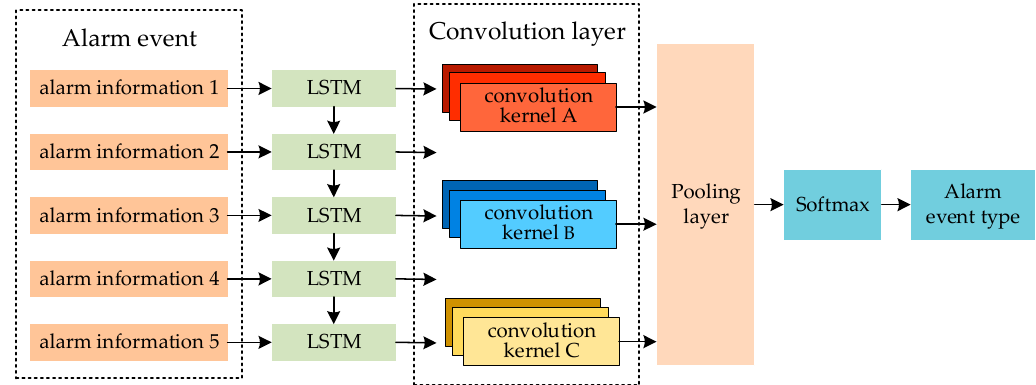
Figure 4. Structure of combined long short-term memory and convolutional neural network (LSTM-CNN) identification model.